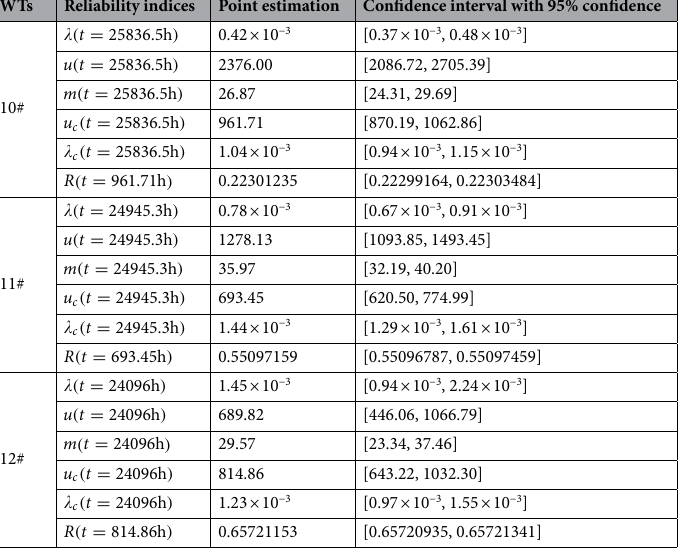
Table 3. Point estimation and interval estimation of reliability